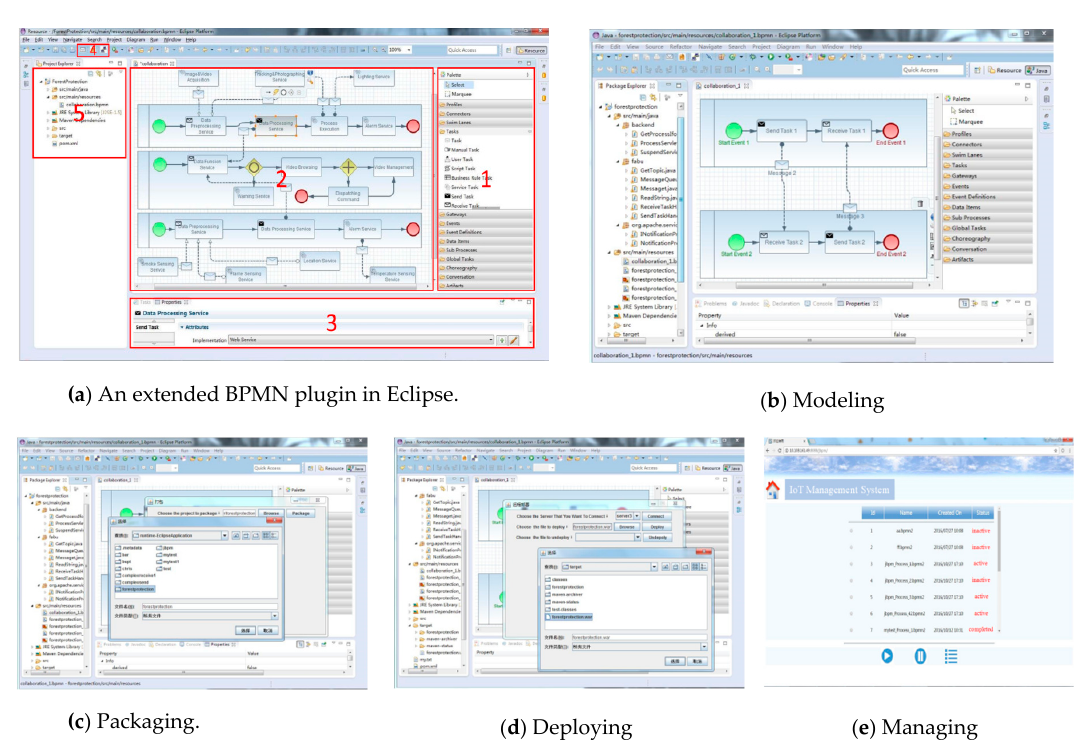
Figure 18. These are screenshots of our designed platform. ( a ) An extended BPMN plugin; ( b ) modeling the business process application; ( c ) packaging the application into a war file; ( d ) deploying the war file to discrete servers; and ( e ) managing the deployed applications.